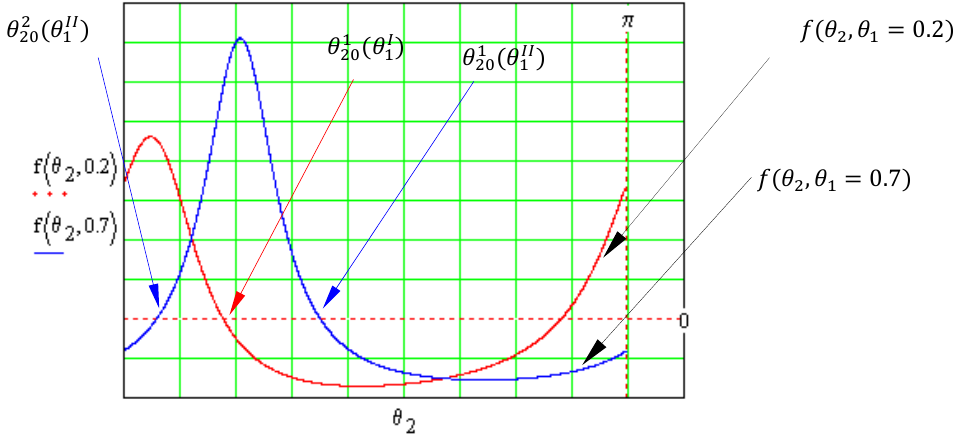
Figure 16. The convergence shift in the numerical algorithm. To avoid this situation, the bipartition method was applied while solving Equation (41). The condition imposed on the solving algorithm is that, for the current iteration, the root of the equation should be searched for in an interval with a center identical to the previous iteration root and of length small enough that the two roots will correspond to the same assembling position of the mechanism. The two possible assembling poses of the mechanism are presented in Figure 17.